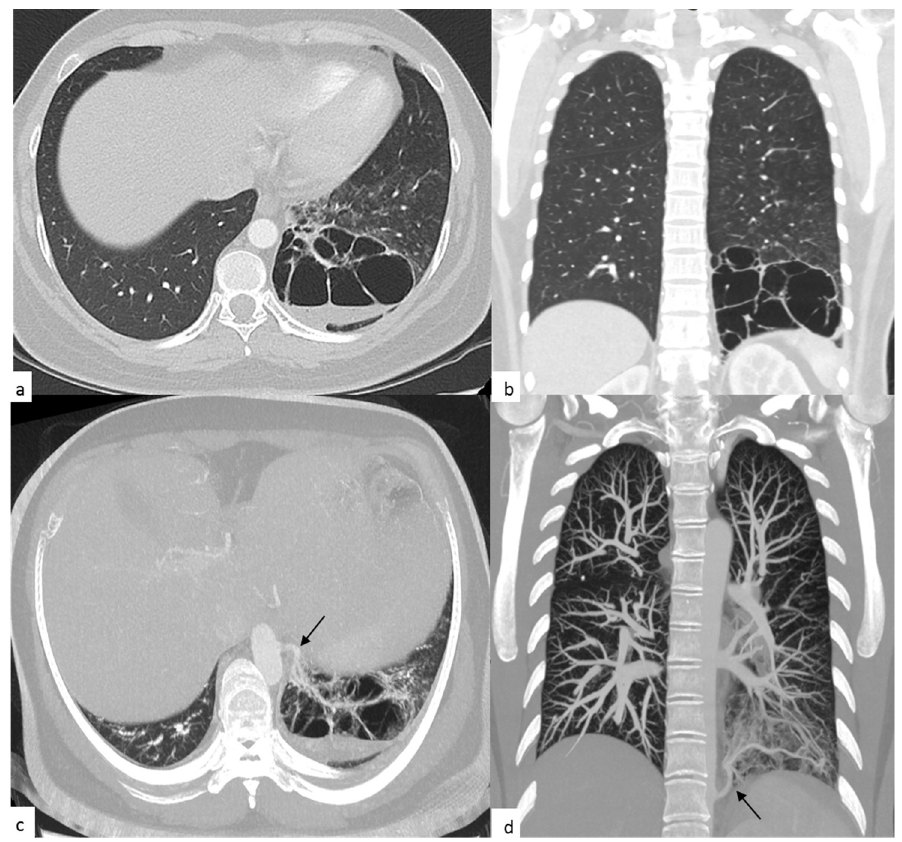
Figure 1. Axial ( a , c ) and coronal ( b , d ) chest computed axial tomography (CT) scan: ( a ) and ( b ): images with contrast show a hypodense, cystic avascular lesion, with multiple internal septa (multicystic) and diameters greater than 67 × 69 × 88 mm (PA × T × L); the cysts measure between 15 and 35 mm, are located in the posterior segment of the left lower lobe, and contain air-fluid levels. Peripheral parenchyma bronchial wall thickening and centrilobular micronodules are also evidenced. ( c ) and ( d ): images obtained using multiplanar reformation (MPR) outline the course of an aberrant arterial vessel (black arrow), which originates from the left lateral aspect of the thoracic aorta and supplies the left basal cystic lesion.